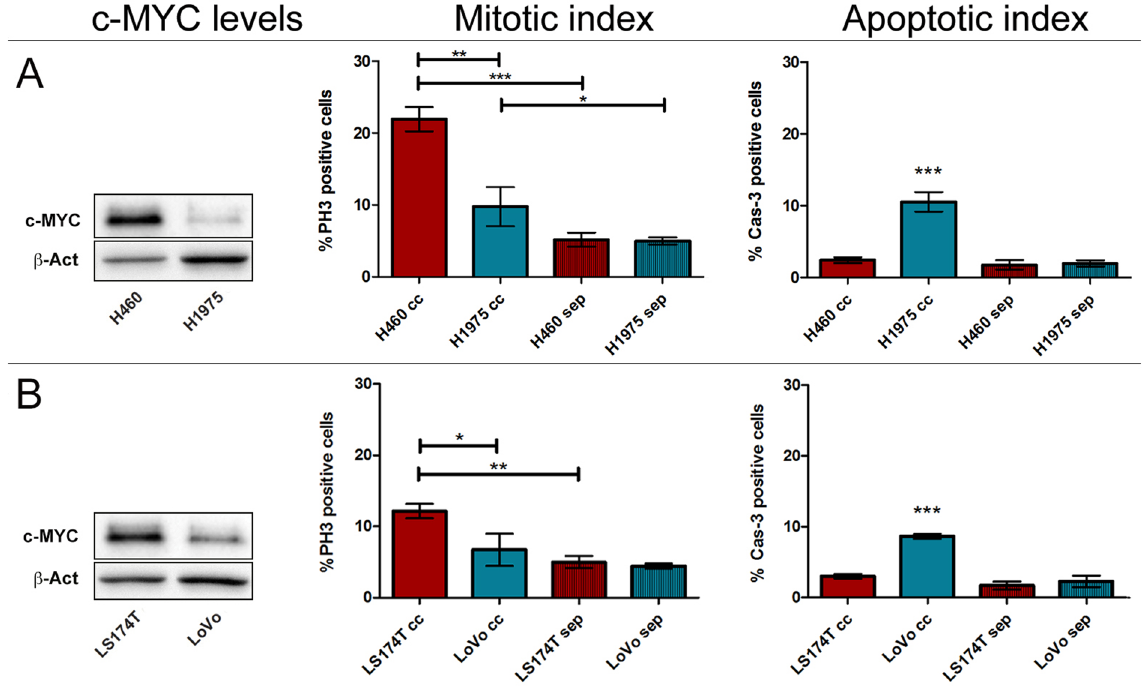
Figure 6. Human cancer cell lines displaying different c-MYC protein levels show competitive behaviours in co-culture. ( A ) H460 vs H1975 lung cancer cell lines. ( B ) LS174T vs LoVo colon cancer cell lines. In each assay, the Western Blotting shows c-MYC protein levels of the two cell lines used and β -actin as a loading control. The Mitotic Index shows the percentage of PH3-positive cells in the two lines after 5 h in co-culture (cc) or separate (sep) conditions; the Apoptotic Index is represented as the percentage of Cas3-positive cells at the end of the assay. Original blots are presented in Supplementary Figure S7. Statistical significance and ± SD are